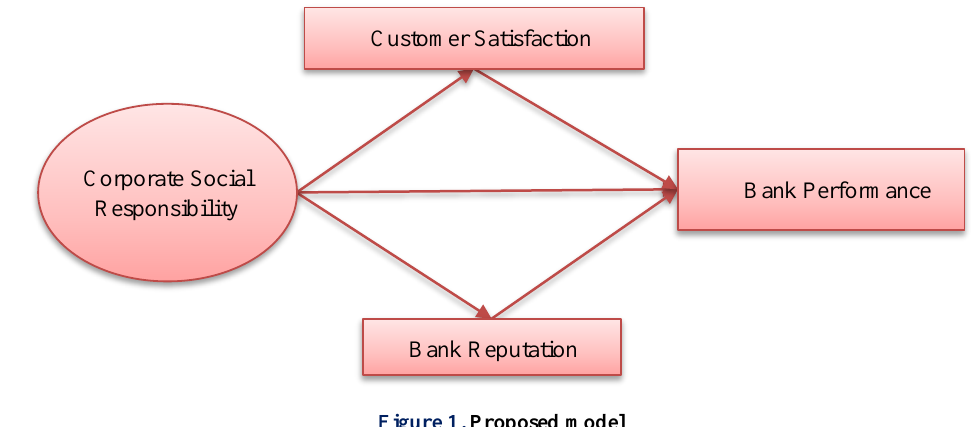
Figure 1. Proposed model